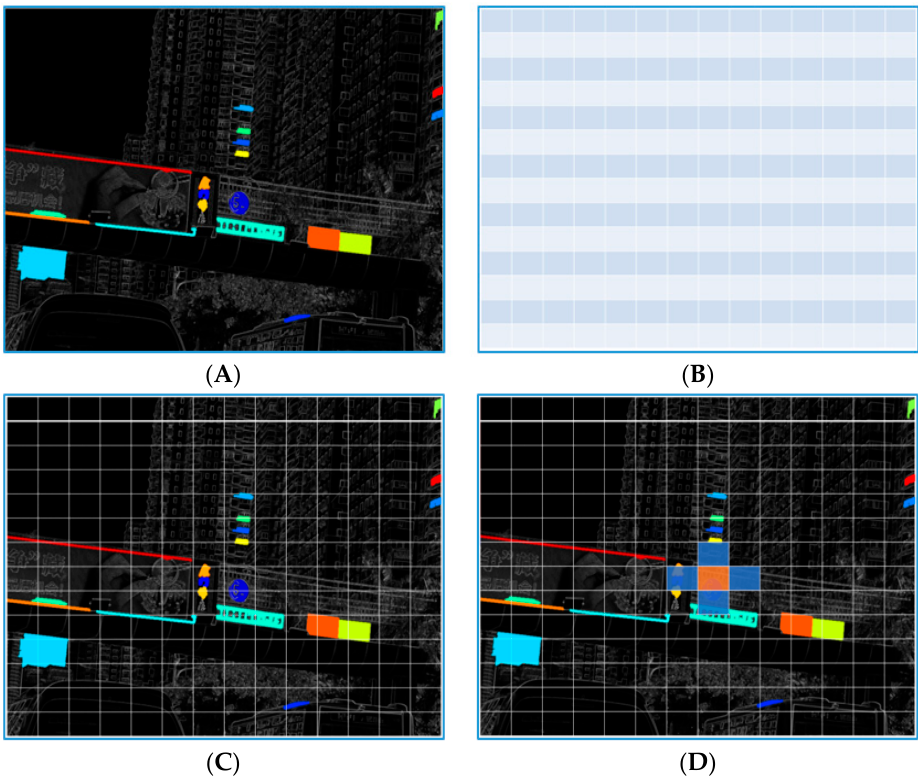
Figure 10. The process of filtering the ROIs of a faster region with a convolutional neural network (R-CNN) with MSERs. ( A ): regions proposal by MSERs, ( B ): anchor points of Faster R-CNN, ( C ) MSERs and Faster R-CNN coincidence proposal regions, ( D ): ROI with SROI information.